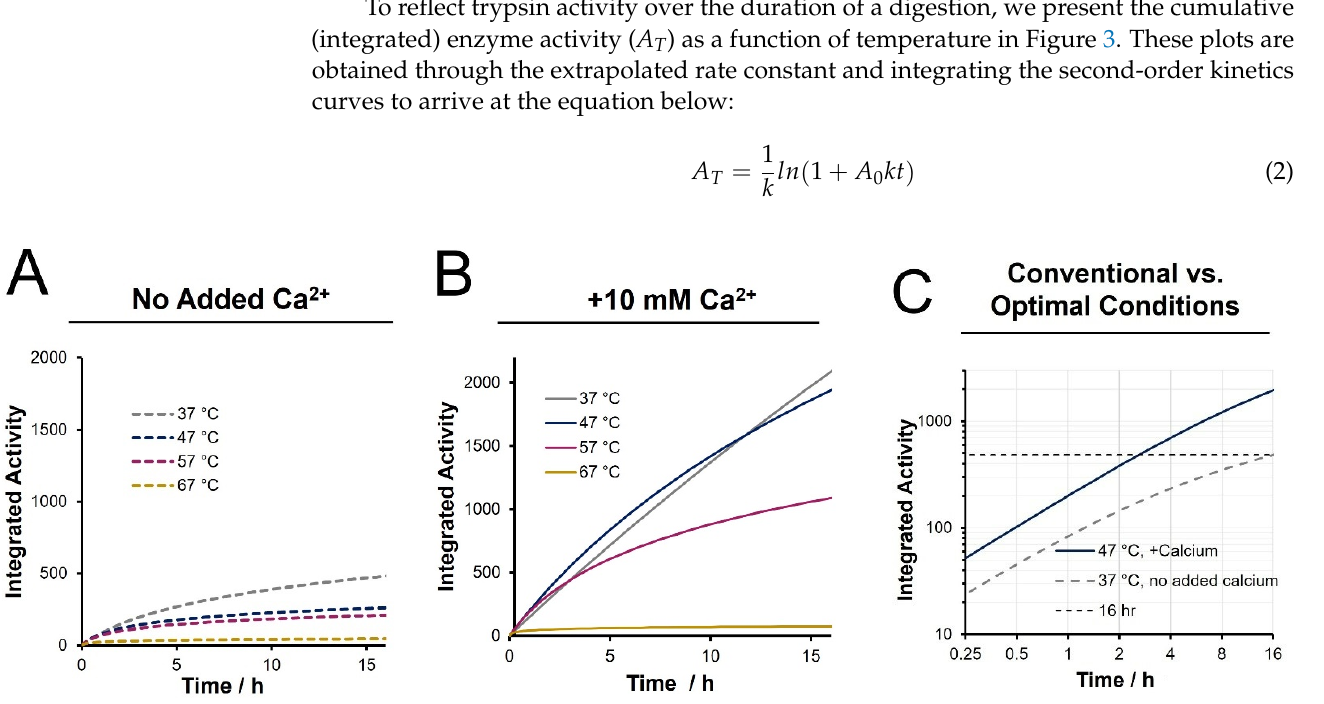
Figure 3. Cumulative activity across a 16 h time course estimated from integrated activity over time ( A ) in the absence of calcium, ( B ) with 10 mM added calcium ions, and ( C ) comparing the proposed optimal condition of 47 °C with 10 mM calcium ions to conventional conditions.